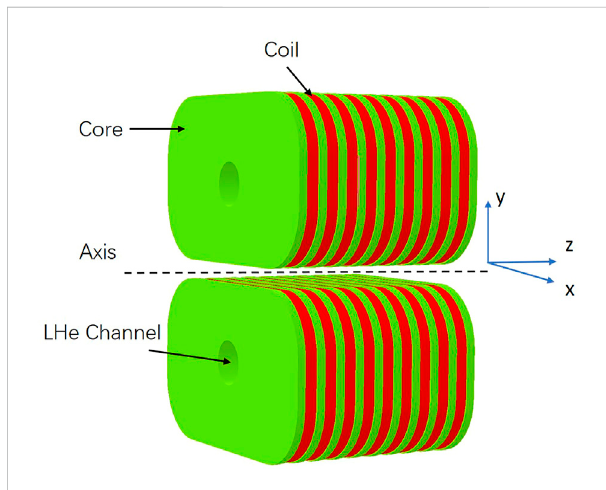
FIGURE 1 Simulation model of the short SCU in the OPERA-3D program.